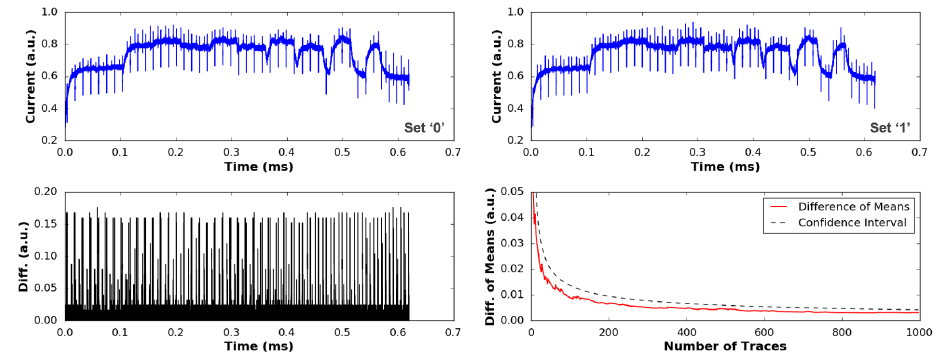
Figure 16: Difference-of-means test for polynomial NTT with representative power traces from set S 0 (top left) and S 1 (top right), difference waveform (bottom left) and difference of means versus number of traces with 99.99% confidence interval (bottom right).